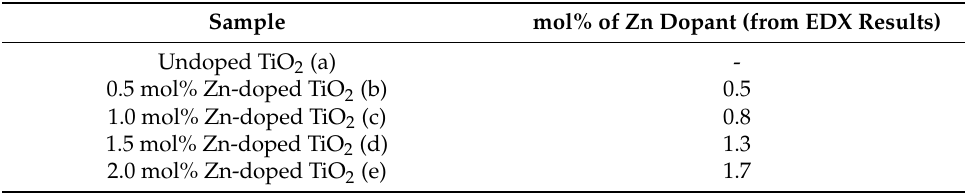
Table 1. Mole percentage of Zn in Zn-doped TiO 2 nanomaterials.